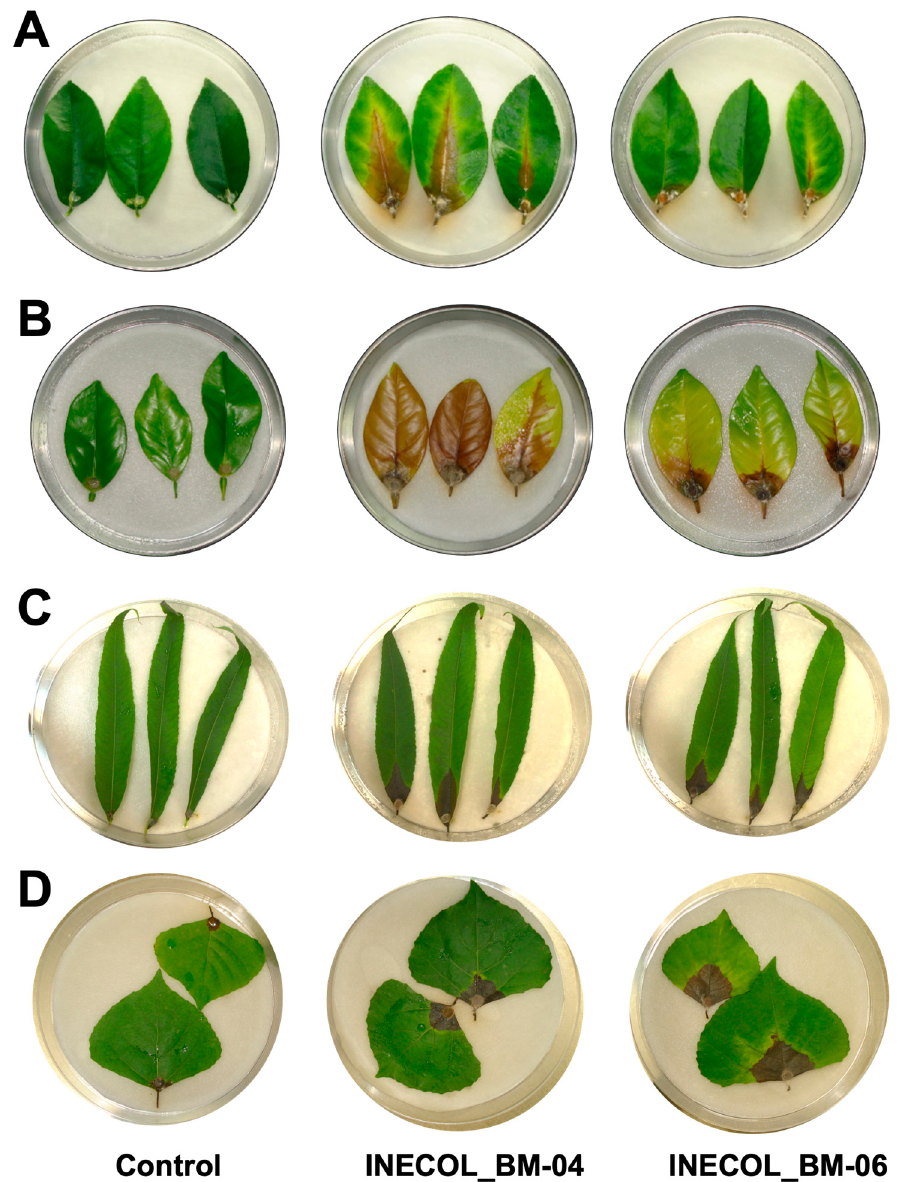
Figure 5. Pathogenicity screening of Fusarium sp. INECOL_BM-04 and Fusarium sp. INECOL_BM-06 in leaves of citrus and forest species. ( A ) Citrus latifolia. ( B ) Citrus sinensis . ( C ) Salix lasiolepis. ( D ) Populus nigra. The photographs were taken at 12 dpi for ( A – D ) and 8 dpi for ( B ).